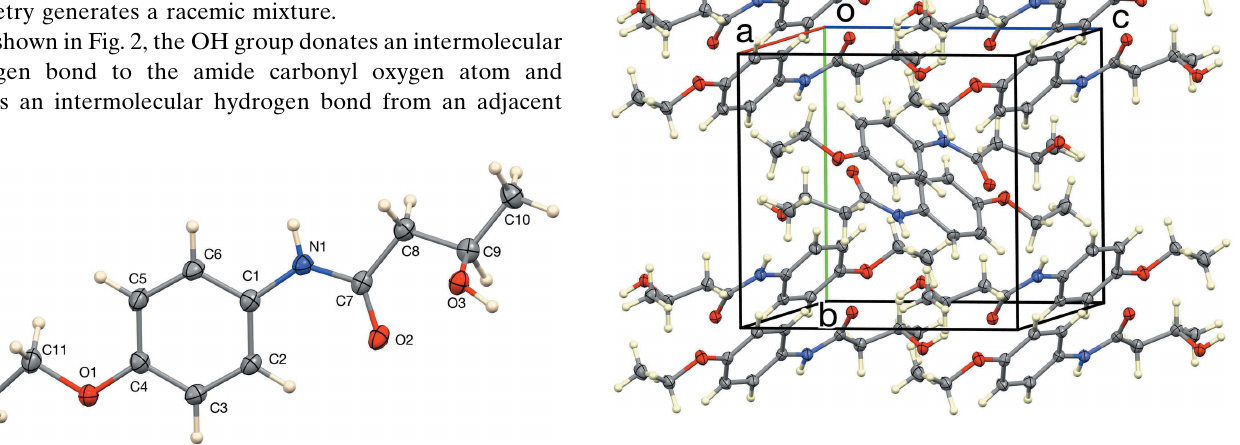
Figure 3 Crystal packing of the title compound N -(4-ethoxyphenyl)-3-hydroxy- butanamide.